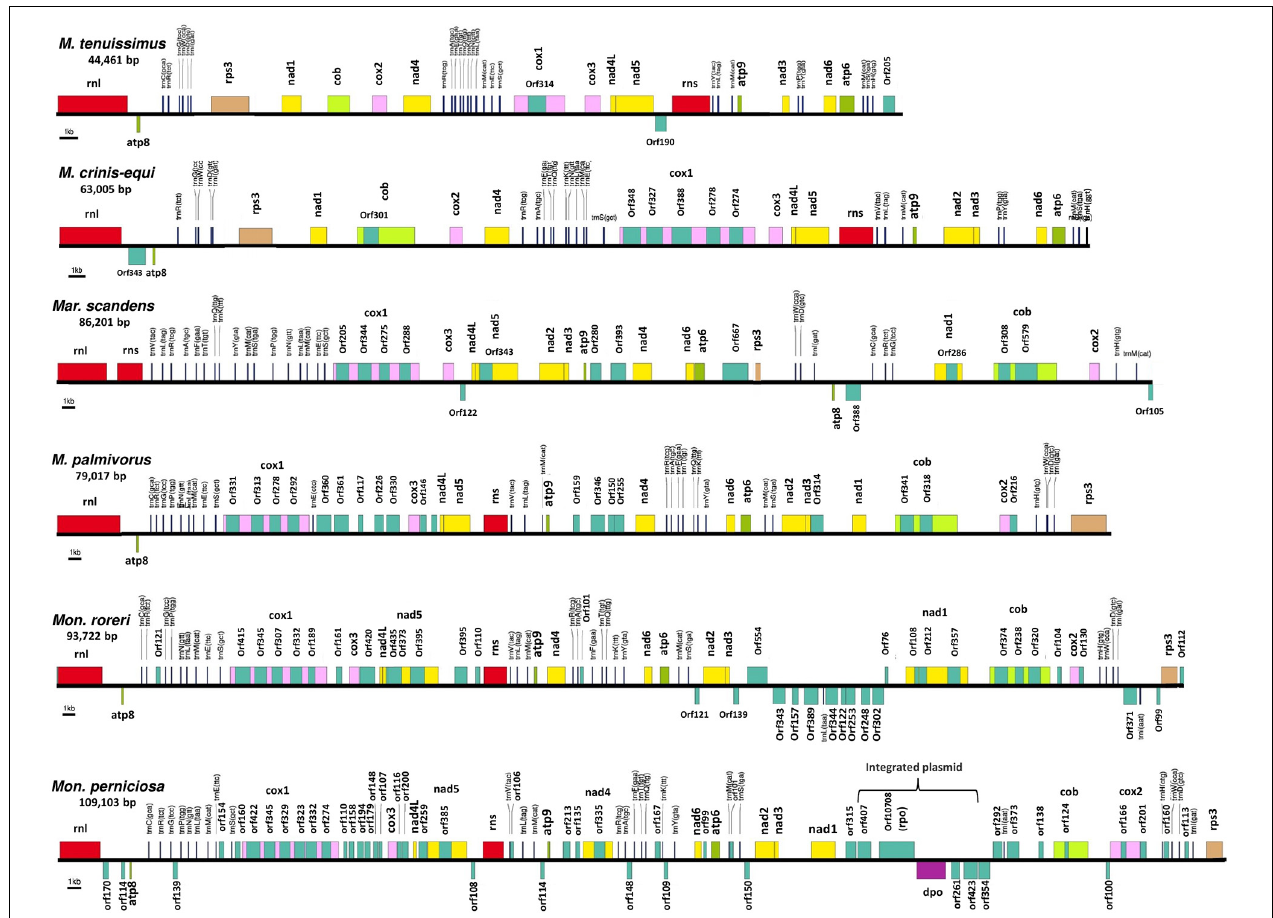
FIGURE 1 | Conservation of gene order and interspecies variation in the mitogenome structure of four cacao thread blight associated pathogens from Ghana and the Western hemisphere frosty pod rot and witches’ broom pathogens of cacao, all basidiomycetes within the Marasmiaceae family. Whole mitochondrial genome sequence involved are Marasmius tenuissimus (GHA07), Marasmiellus scandens (GHA19), Marasmius crinis-equi (GHA76); Marasmius palmivorus (GHA12), Moniliophthora roreri (Genbank no. HQ259115.1), Moniliophthora perniciosa (Genbank no. AY376688.1). Mitochondrial gene annotation was performed with MFannot using the NCBI translation code 4, and the physical map of the mitogenomes were created with OrganellarGenome-DRAW (OGDRAW) v